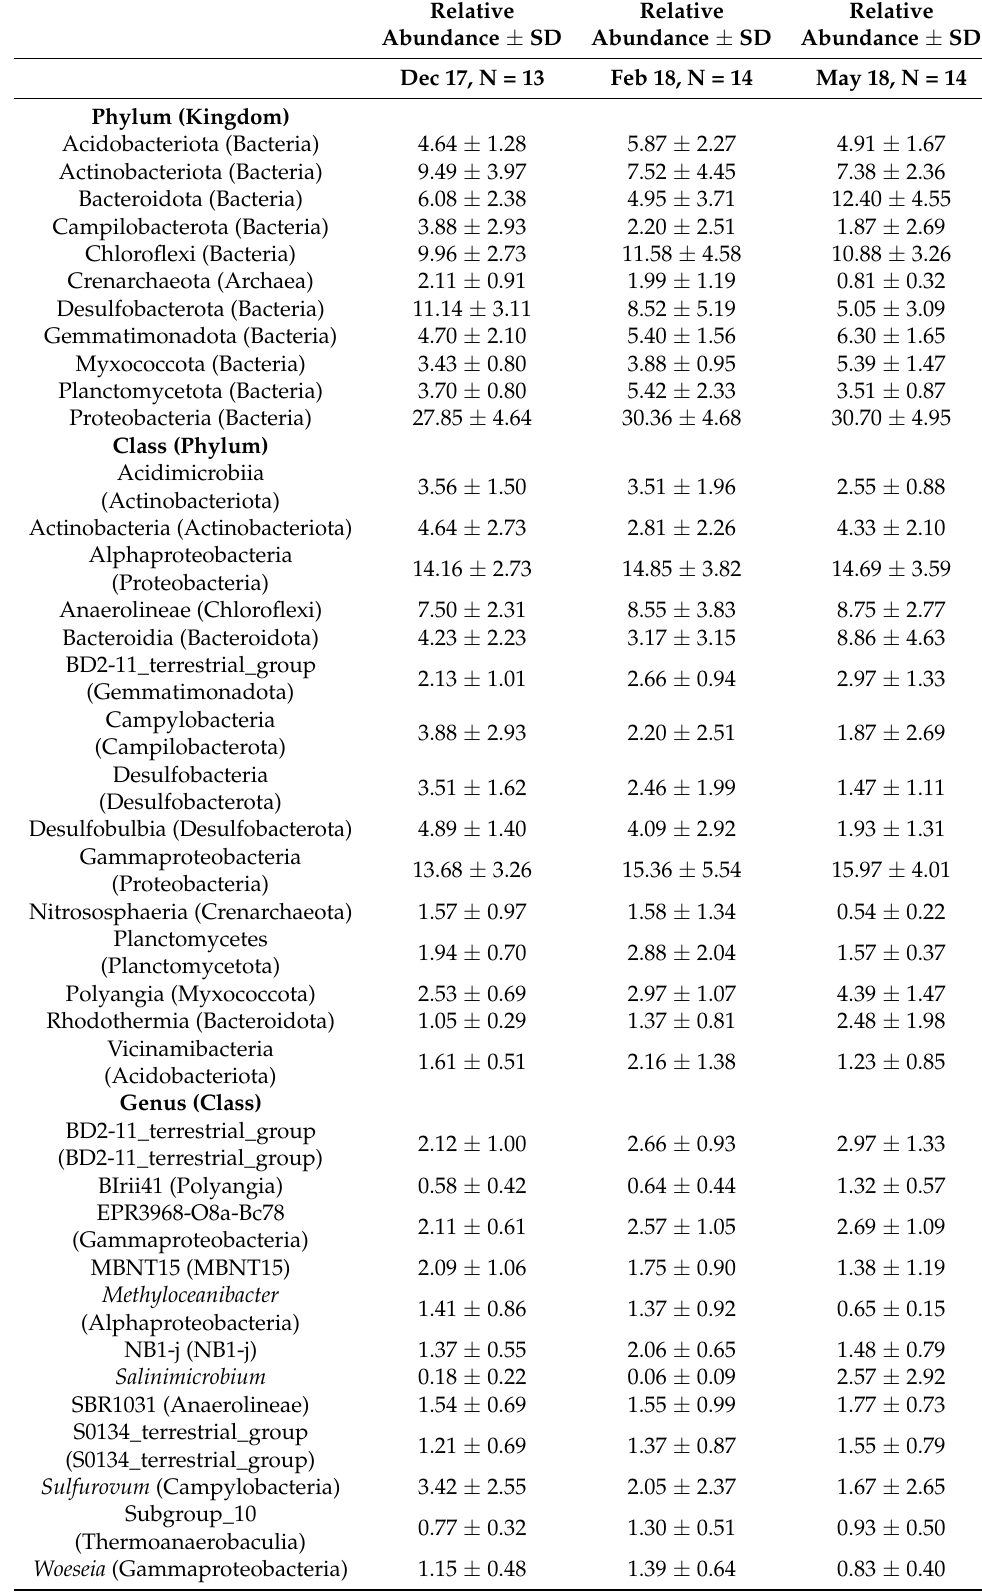
Table 2. Relative abundance (% ± SD) through time of the most common bacterial taxa in Juan D í az. Specifically, in the transition from rainy (Dec 2017) to dry (Feb 2018) to rainy (May 2018)